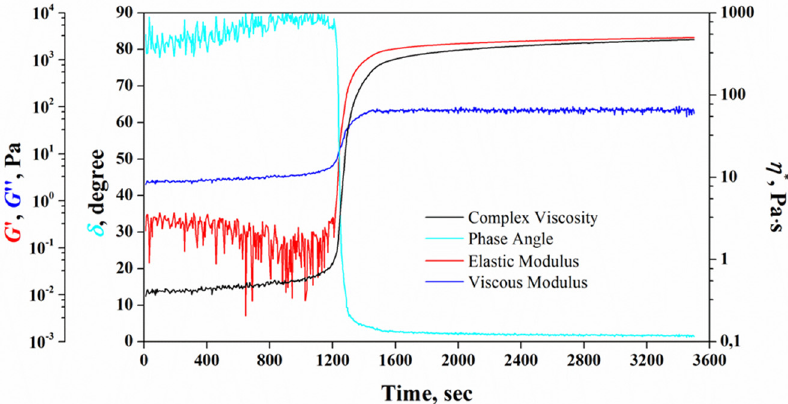
Figure 17. Kinetics of Nanoembosil ® formation. Reprinted with permission [68]. Copyright 2021, Elsevier.